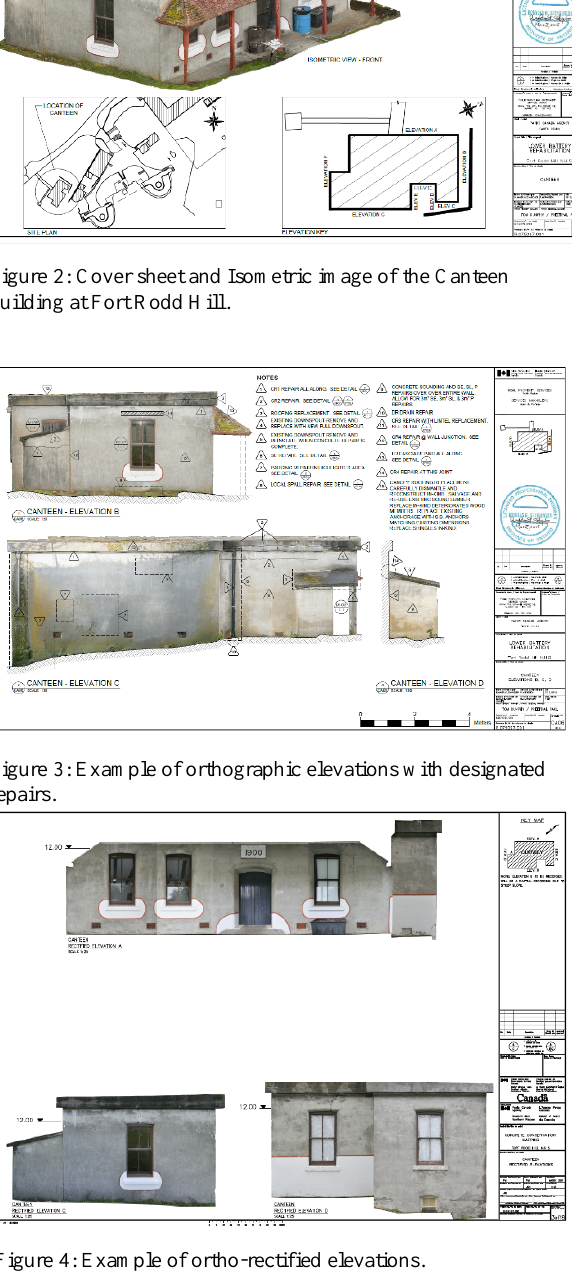
Figure 4: Example of ortho-rectified